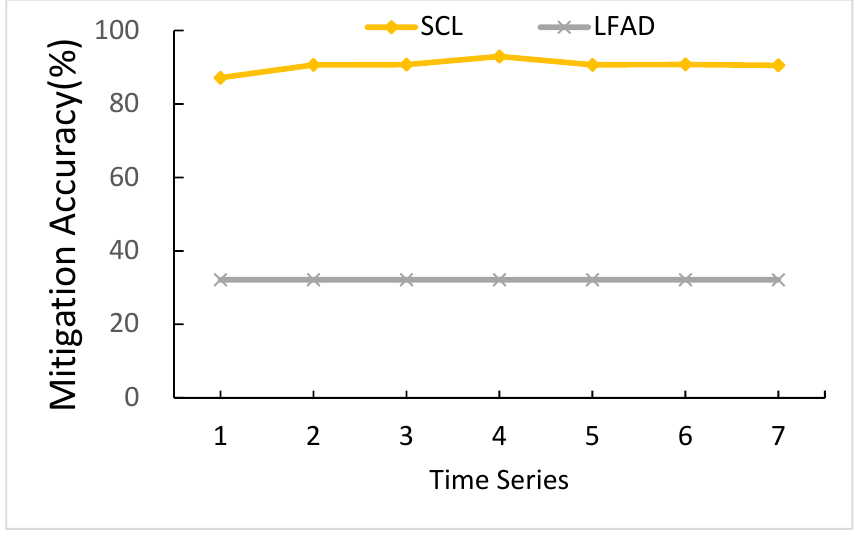
Figure 15. Comparison of different time series.